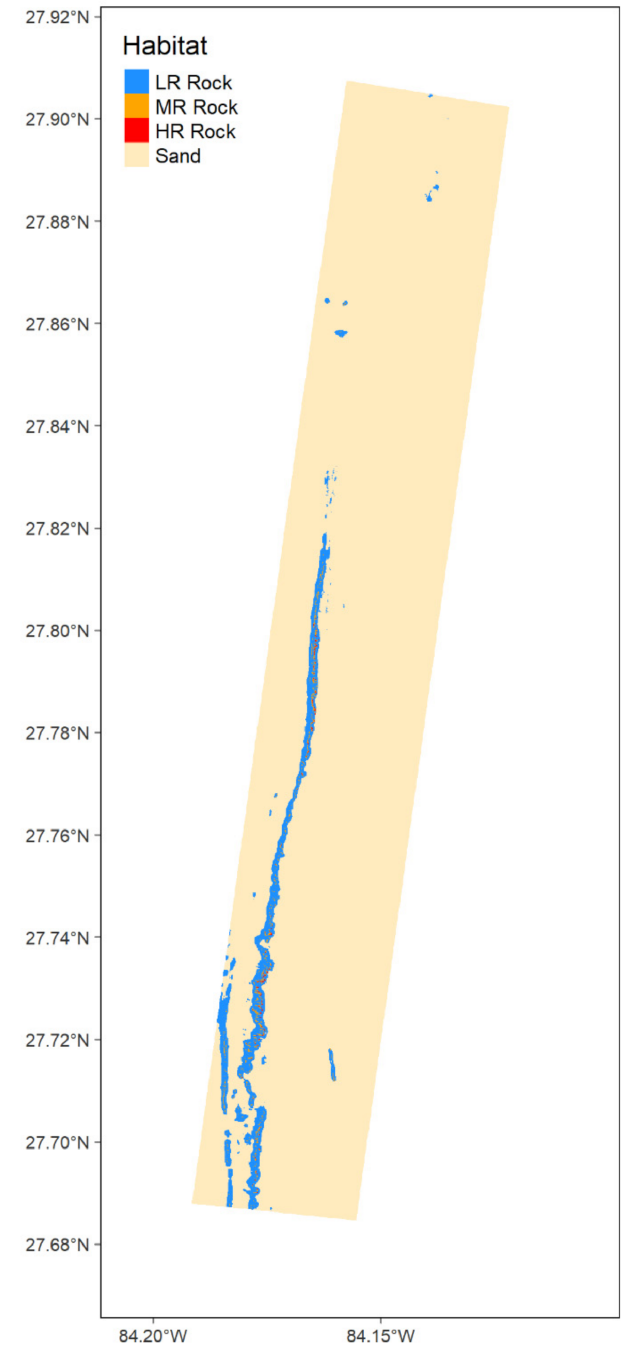
Figure 12. Combined substrate and vertical relief map of the Elbow of the west Florida shelf with 10 m × 10 m resolution determined through supervised (random forest) classification and maximum vertical relief calculated from the bathymetry around a central pixel. Thresholds for vertical relief were low relief <1 m, moderate relief >1 and ≤ 2 m, and high relief >2 m